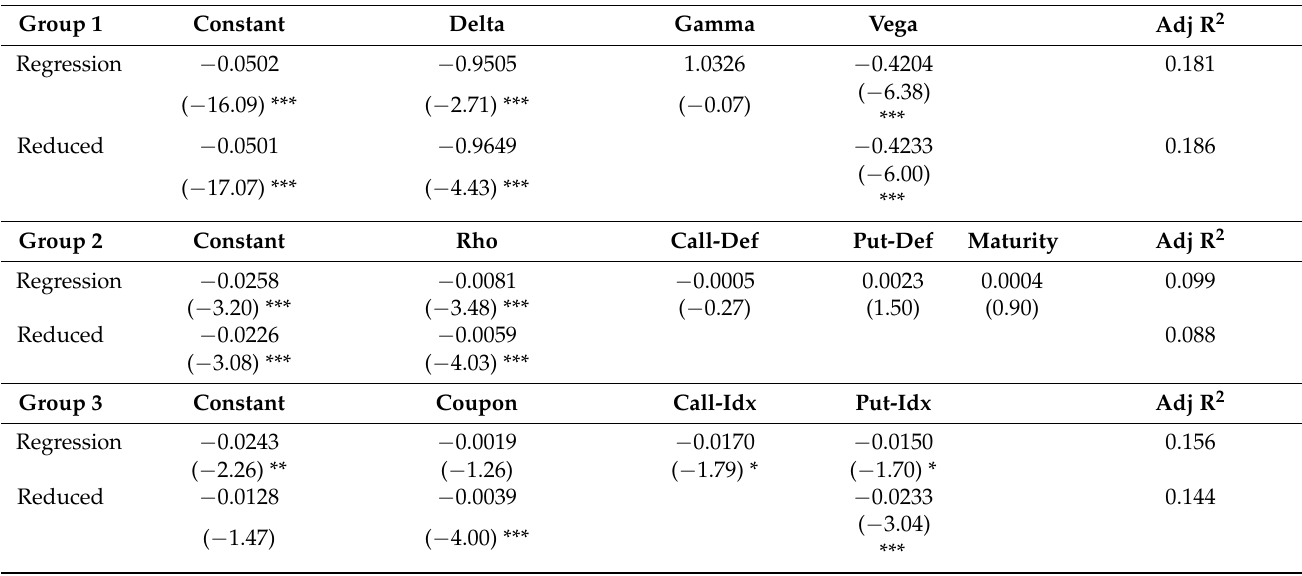
Table 5. Cont. Panel B: Regression estimates for variables in Groups 1, 2 and